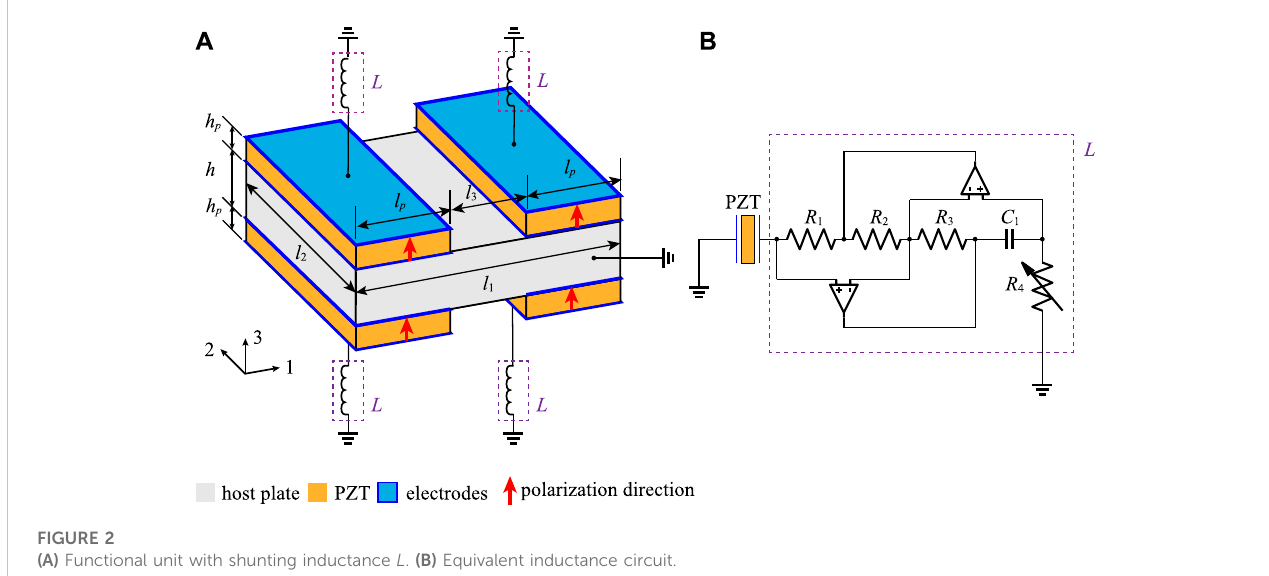
FIGURE 2 (A) Functional unit with shunting inductance L . (B) Equivalent inductance circuit.